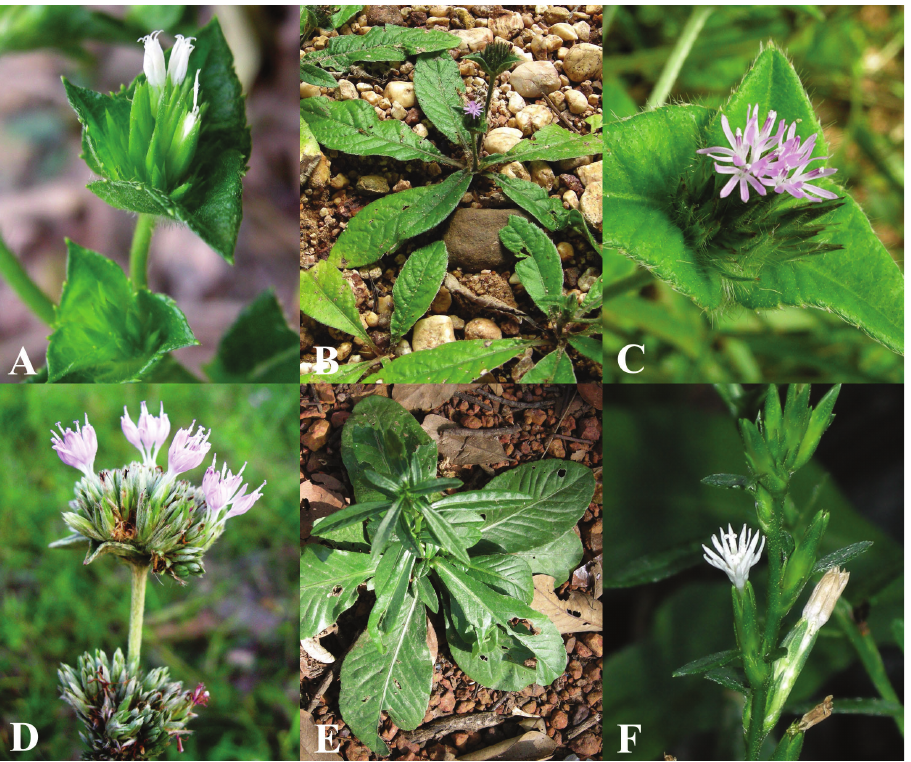
Figure 8. Morphology of Vernonieae in Thailand 4. A Elephantopus mollis B–C Elephantopus scaber D Elephantopus scaber var. penicillatus E–F Pseudelephantopus